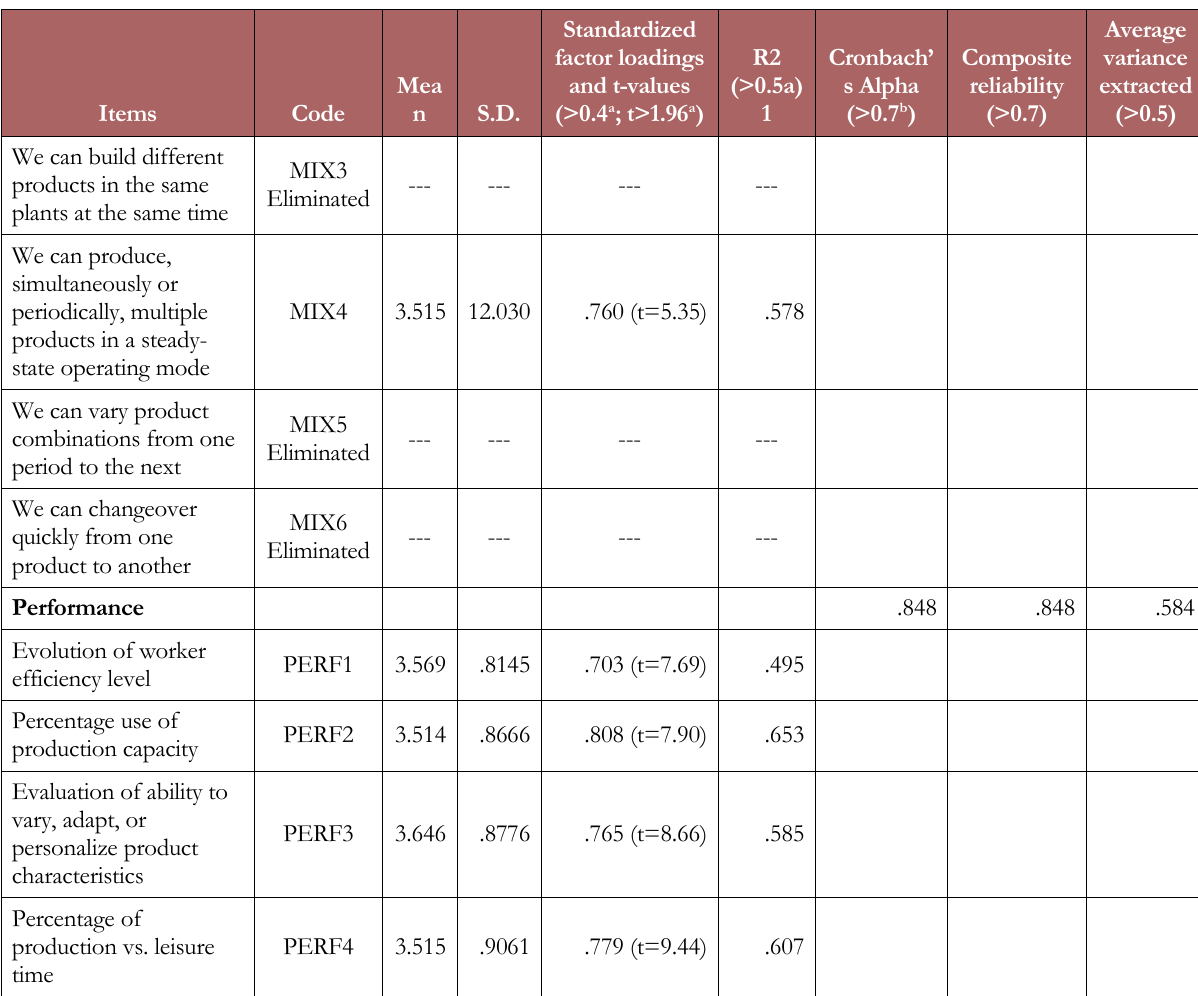
Table 5. Scale items and